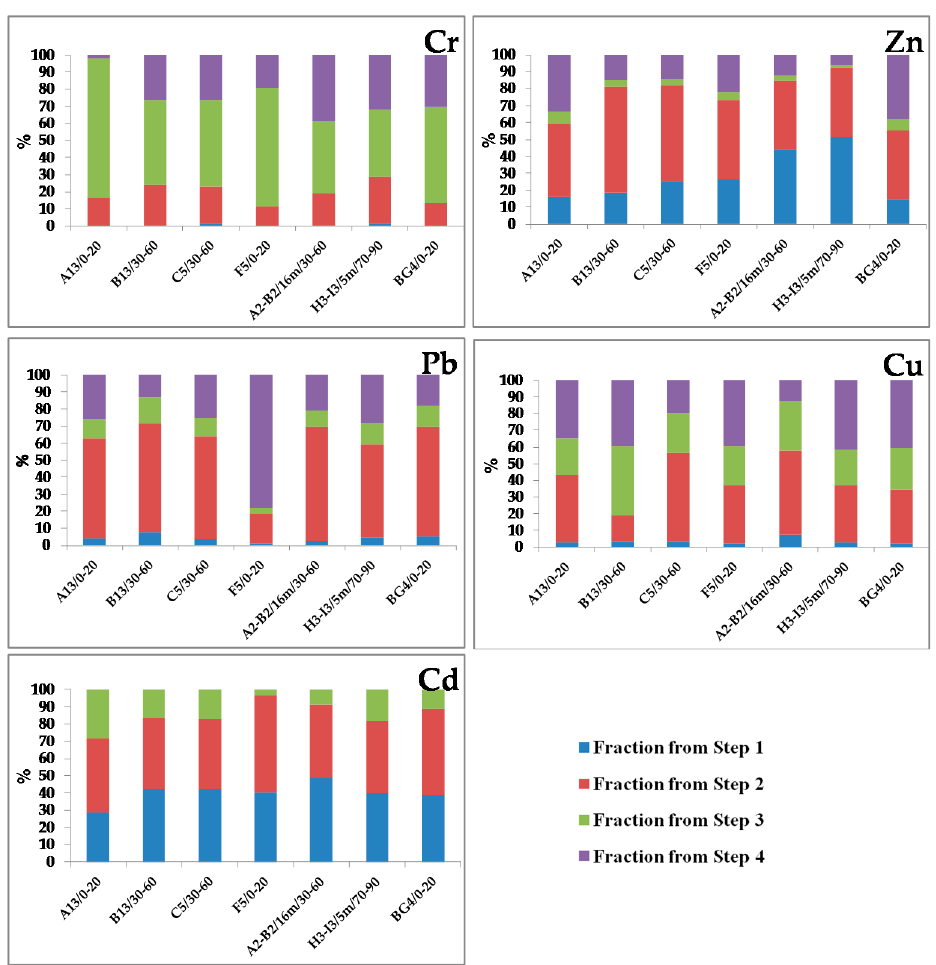
Figure 3. BCR sequential extractions of Cr, Zn, Pb, Cu, and Cd from 7 of the 10 selected soil samples. For each element, the distribution is shown in percentage terms.